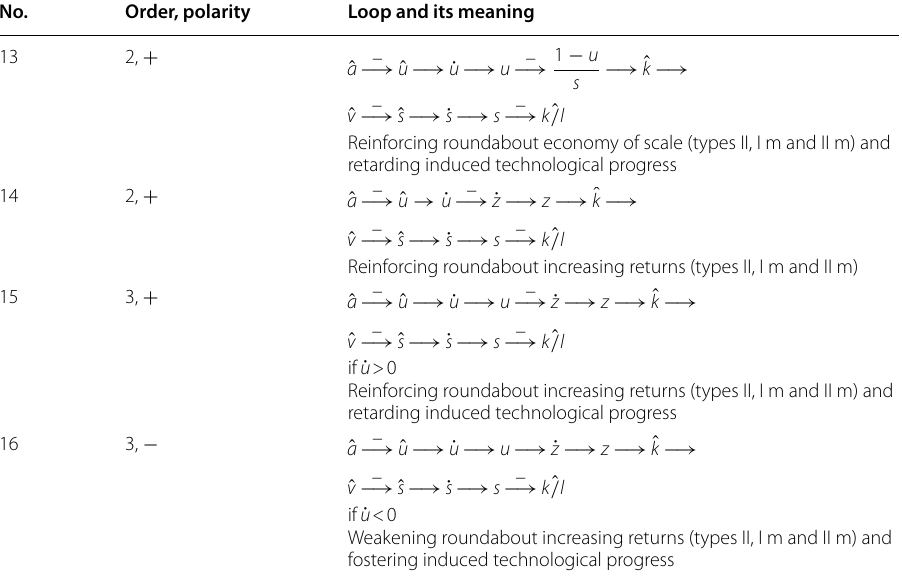
Table 12 Growth rate of output per worker in new extensive feedback loops in L-2